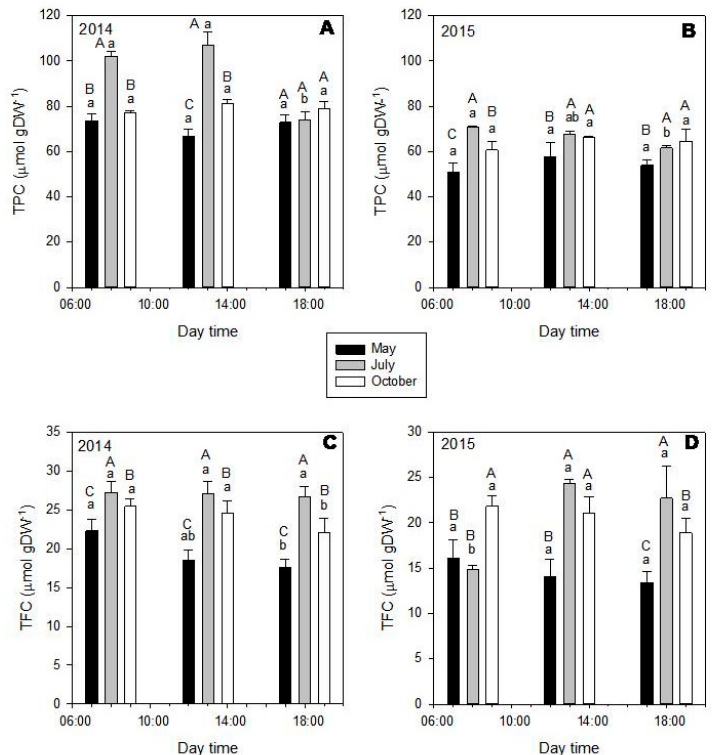
Figure 8. Total phenolic (TPC—upper graphics) and total flavonoid contents (TFC—down graphics) of Pistacia lentiscus extracts of leaves harvested in 2014 (left) and 2015 (right), during the different months (May—black bars; July—gray bars; October—white bars) and day times (8:00; 13:00; and, 18:00). In general, July was the month with the highest amount of TPC and TFC, followed by October and then May. Almost any variation related to time of the day was observed. Mean values ± SD in μ mol gDW -1 ( n = 3). Data was analyzed by two-way ANOVA test, with Tukey post-test, after variance homogeneity analysis by Levene’s test and normality analysis by Shapiro–Wilk test. Equal capital letters indicate no statistical differences between the monthly results (at the same time) and lowercase letters indicate no statistical differences between daily results (inside the same month) ( p ≤ 0.05).